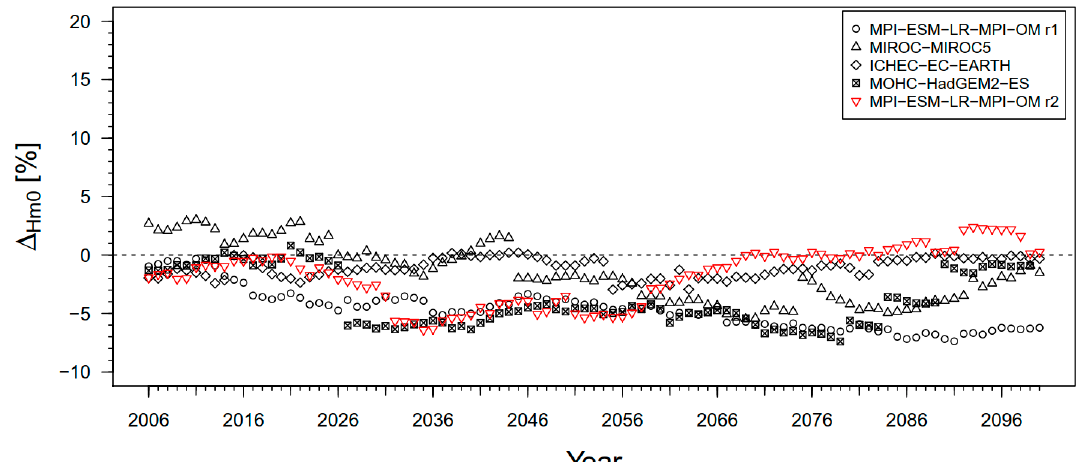
Figure 3. 40-year running mean of the future relative changes of the significant wave height ( ∆ H m0 ) for the log-normal distribution function and a return period of 200 years compared to the reference period 1961–2000 for the ensemble members of the forcing scenario RCP8.5 (see Table 1) near “Rostock-Warnemünde”. Table 4 . Range of future changes of extreme wave heights near the selected locations and for dif- ferent forcing scenarios and time periods of 40 years between 2006–2100 compared to the reference period 1961–2000.